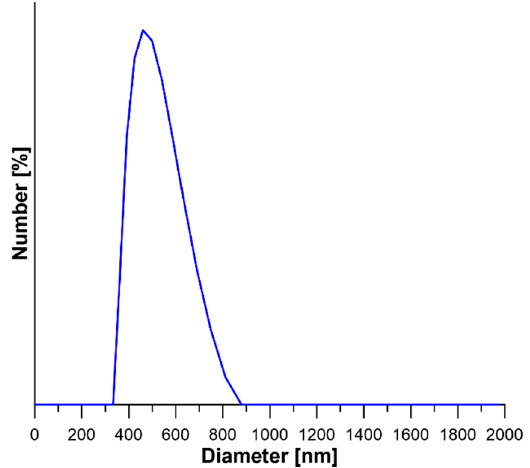
Figure 3. DSL of NaY particle size distribution.